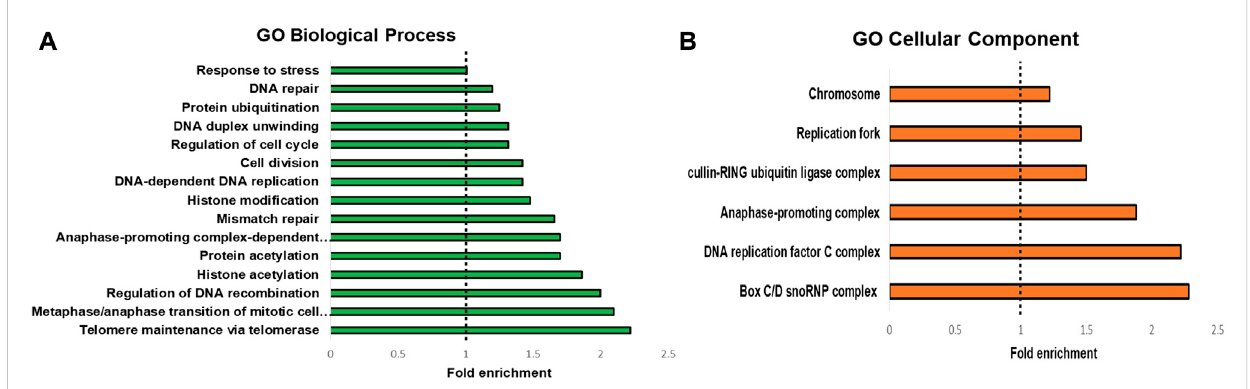
FIGURE 3 GO analysis of T. brucei TERT interactome. STRING GO analysis (A) Enrichment by Biological process. The top 15 enriched GO terms are shown. (B) enrichment by Cellular component. The top 9 enriched GO terms are